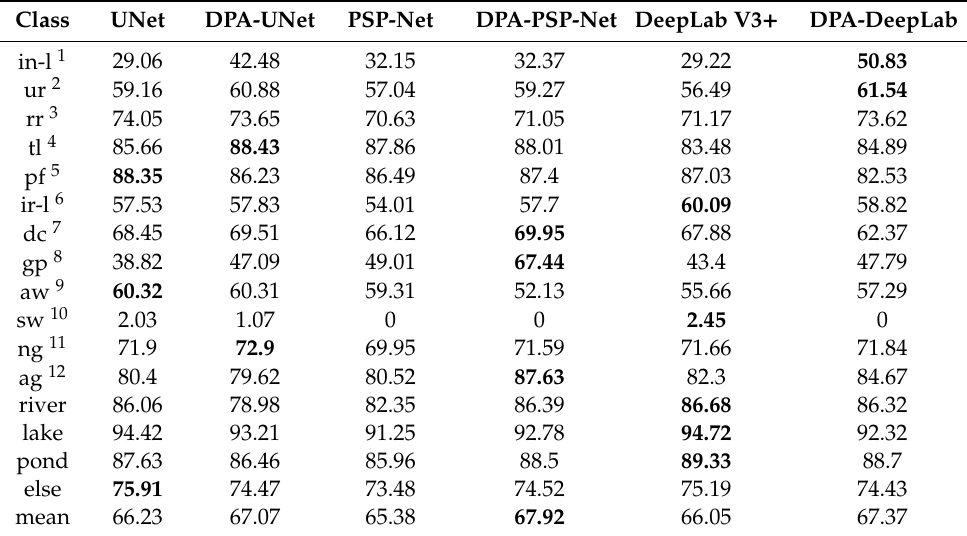
Table 9. Mean IoU for each category using di ff erent models.